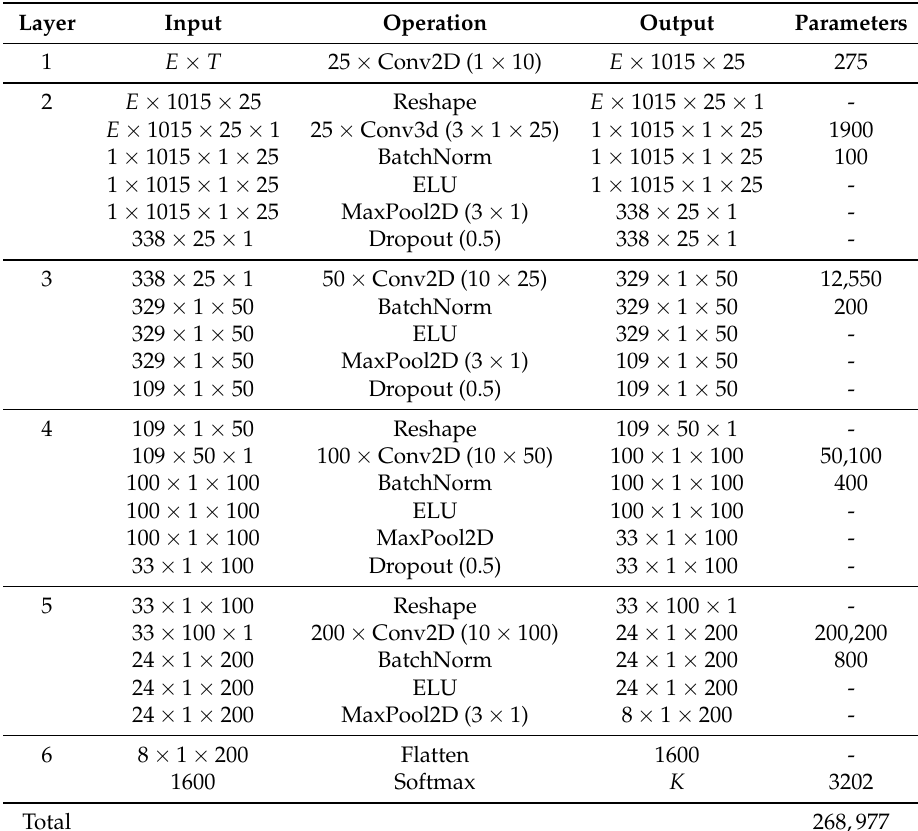
Table A2. Deep CNN (dCNN) architecture as proposed by Schirrmeister et al. [18] (re-implemented in this work), where E is the number of channels, T is the number of timesteps and K is the number of classes. Input and Output sizes are shown for cropped training with E = 3 (electrodes C3, C4, and Cz) and T = 1024 for window size of 4 s; binary classification with two classes for K = 2.